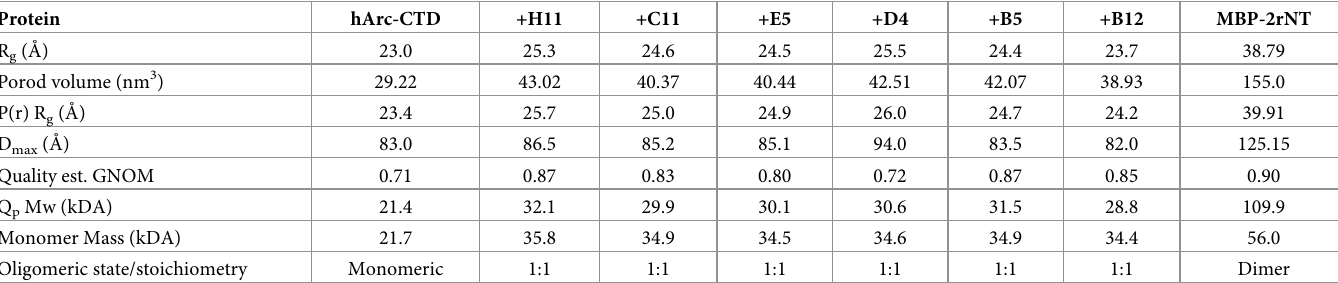
Table 4. Size and shape parameters for CTD-Nb complexes and rArc-NTD, based on SAXS.